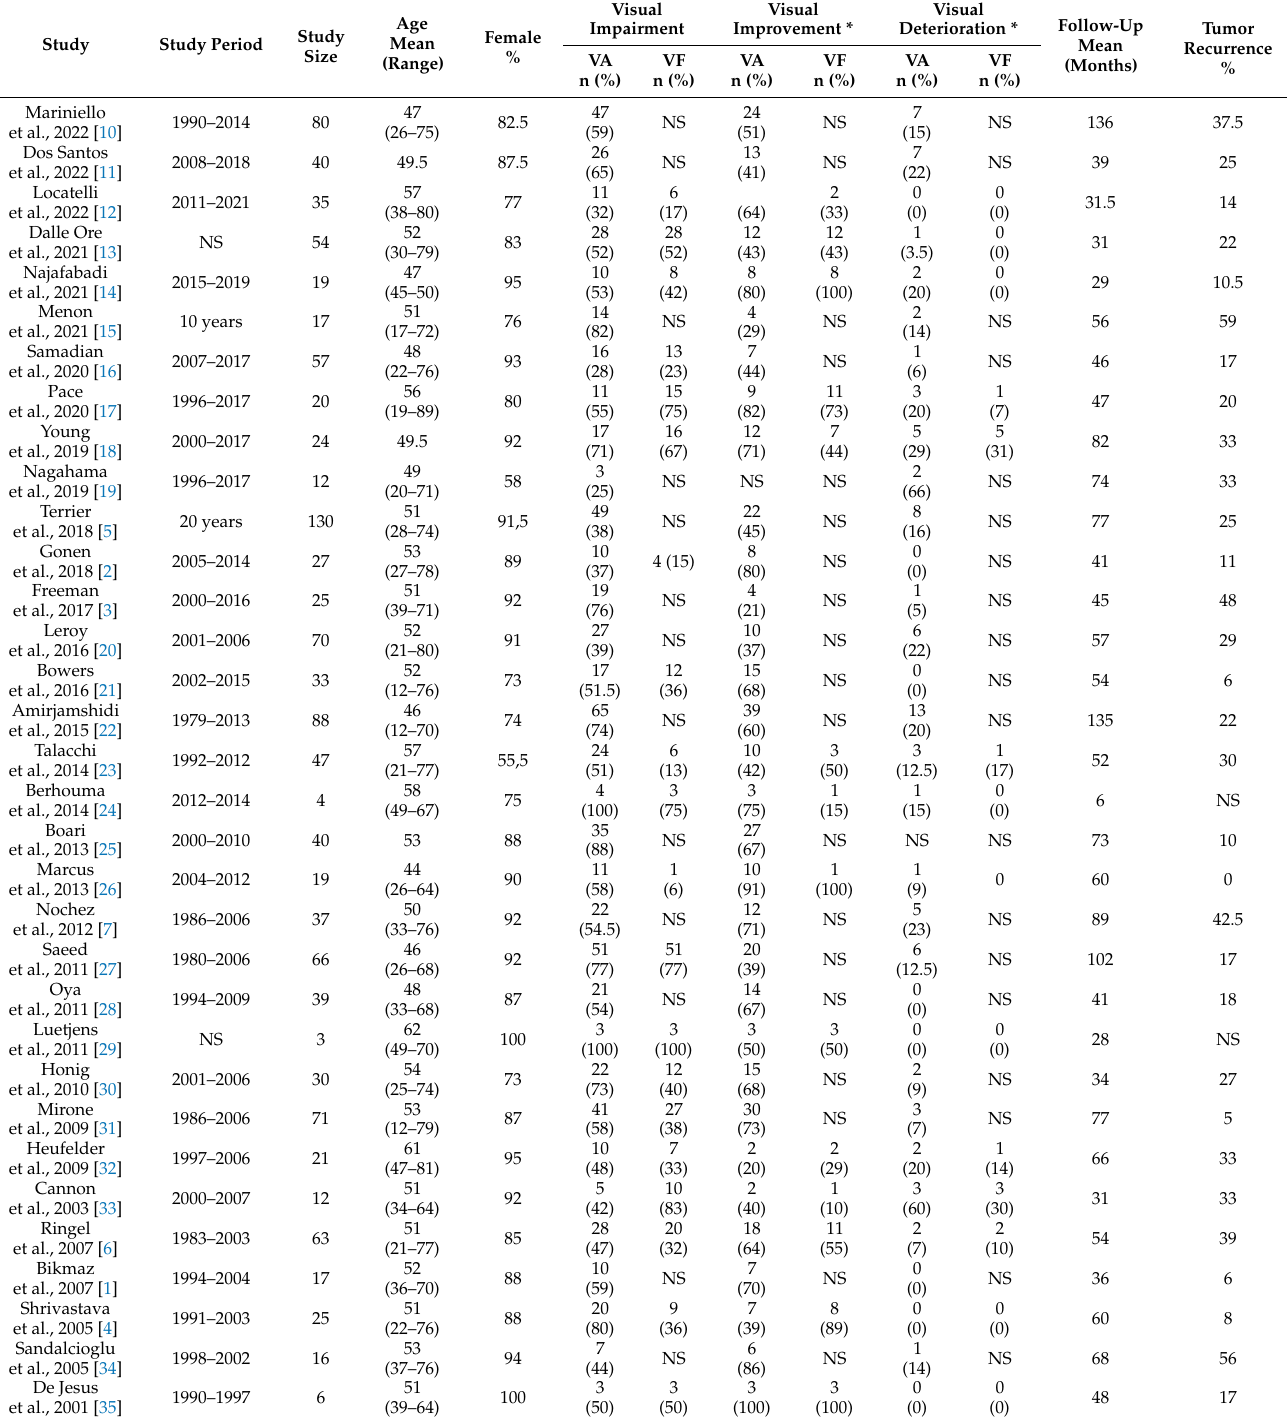
Table 1. Characteristics of the studies included in the